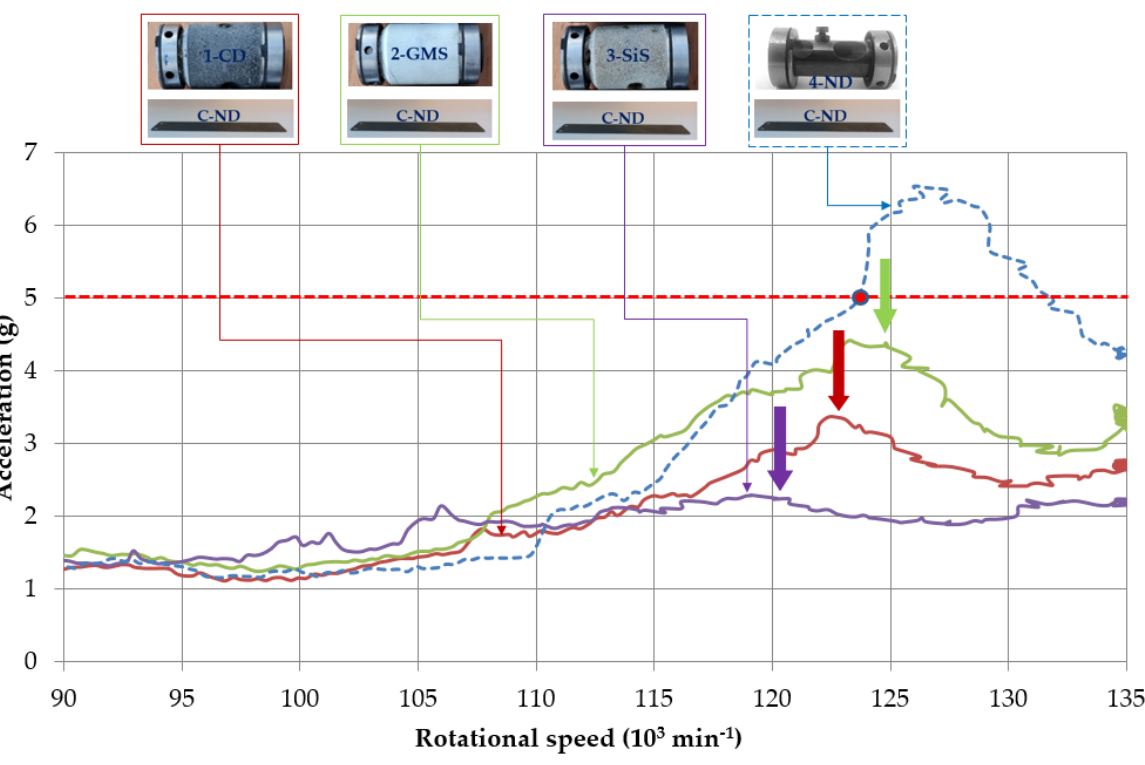
Figure 6. Dynamic responses of rotor housing design modification effect (continuous) and comparison with native design (dashed).